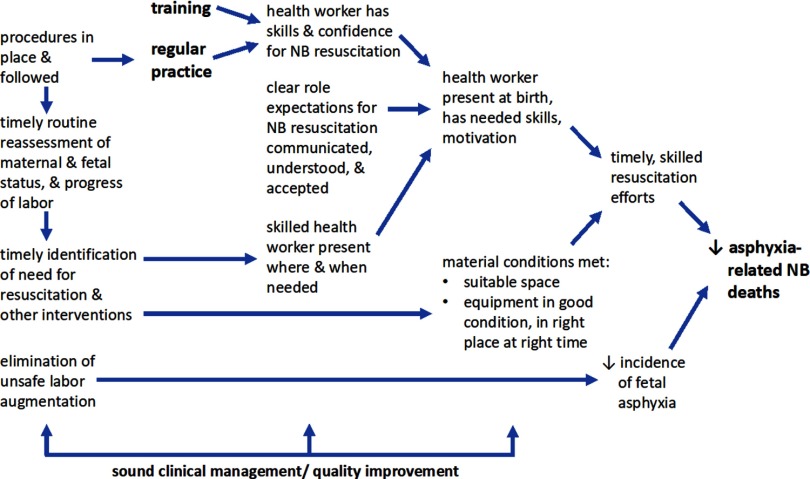
What Will It Take to Drive Down Asphyxia-Related Newborn Deaths?